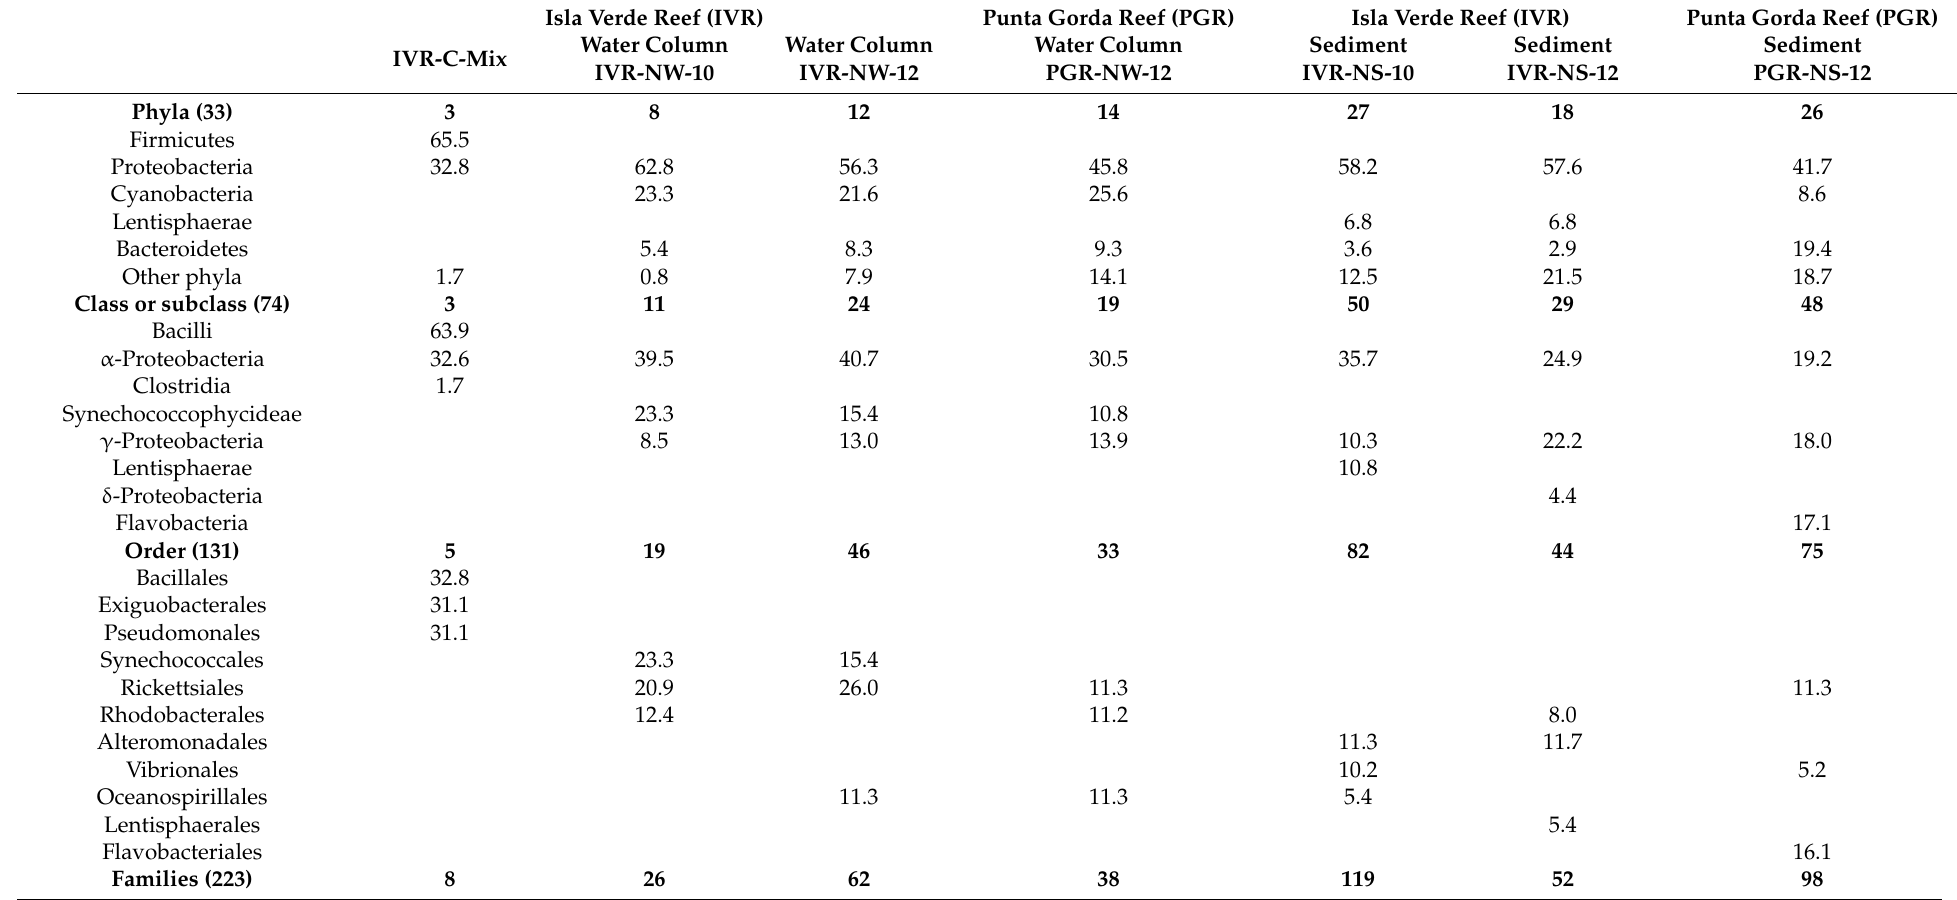
Table 4. Taxonomic distribution (% total) of bacterial populations from the water column and sediments compared with cultured isolates from Isla Verde reef (IVR), classified by pyrosequencing of 16S rRNA. Only specified groups representing > ca. 3% of the total bacterial assemblage are included. Mixed cultures (Isla Verde Reef) = IVR-C-Mix; Water column (IVR) = IVR-NW-10 (September 2010); IVR-NW-12 (March 2012); Water Column (Punta Gorda Reef) = PGR-NW-12 (May 2012); Natural sediment (Isla Verde Reef) = IVR-NS-10 (September 2010); IVR-NS-12 (March 2012); Natural sediment Punta Gorda Reef = PGR-NS-12 (May